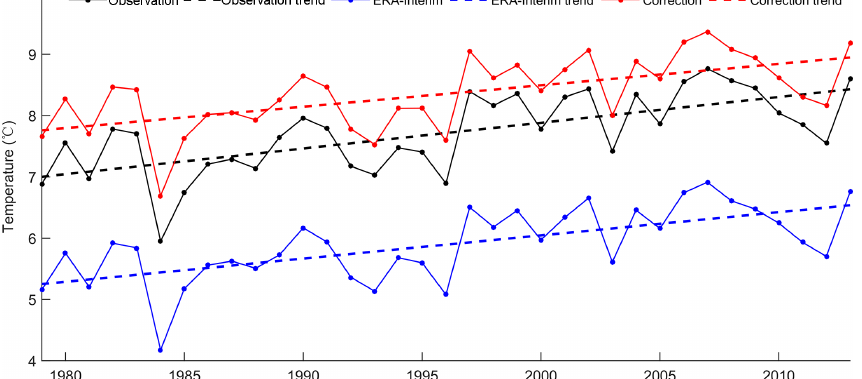
Figure 9. Temporal variations of annual temperatures for observation, original ERA-Interim, and the correction temperatures for the 24 sites in 1979–2013.